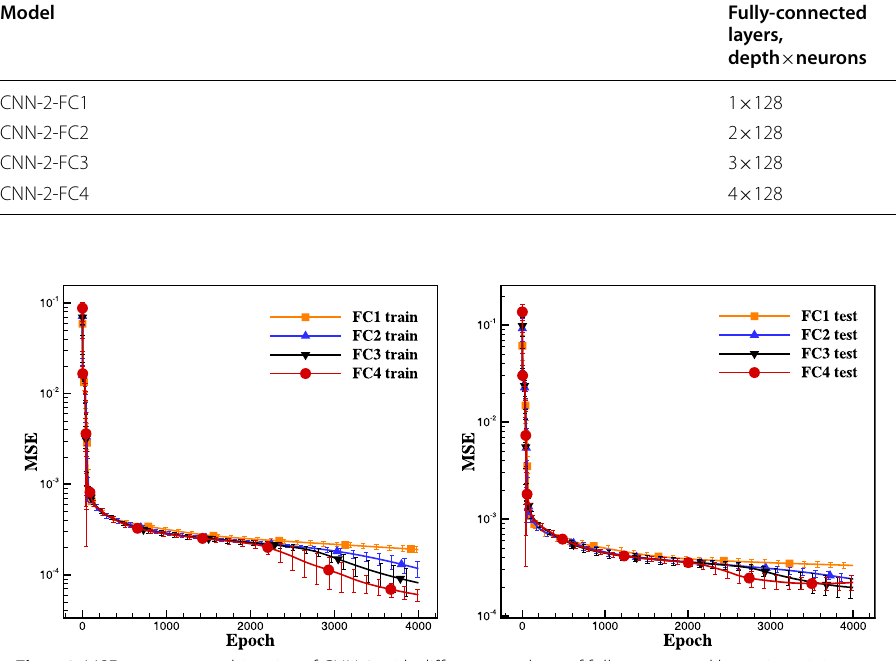
Fig. 16 MSE convergence histories of CNN‑2 with different numbers of fully‑connected layers in training dataset (left) and test dataset (right) (e.g., FC2 indicates two fully‑connected